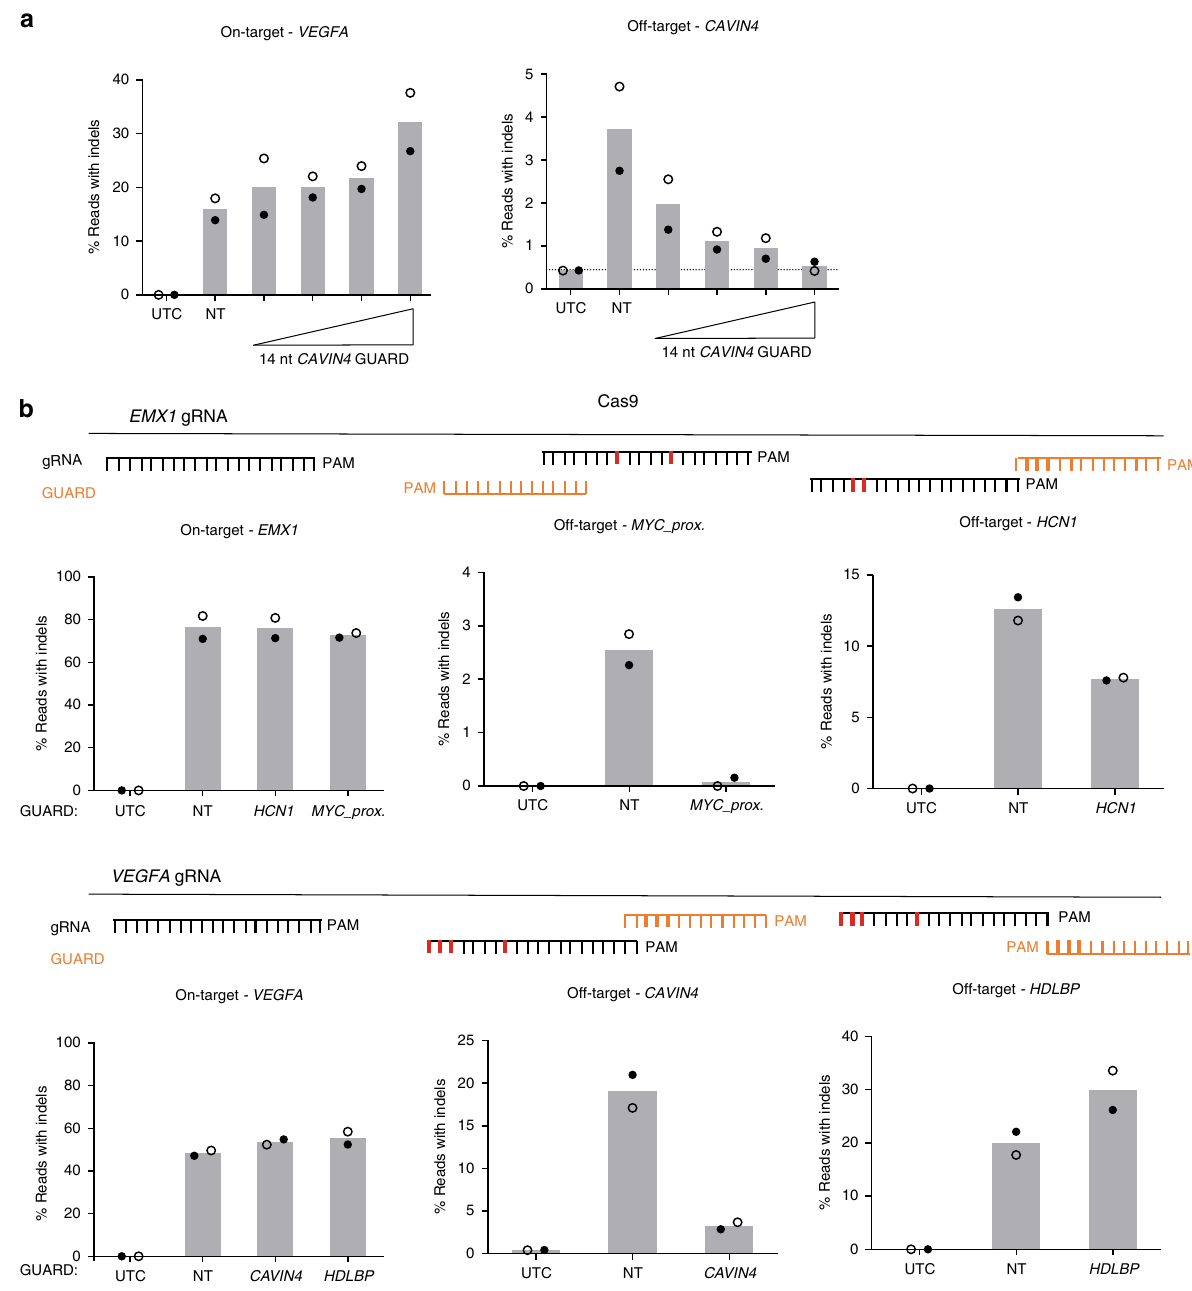
Fig. 3 Protection of multiple, endogenous off-target sites with CRISPR GUARD. a Increasing GUARD RNA concentration leads to complete protection of Cas9 off-target sites in cells. Indel rates from NGS of amplicons from Cas9-expressing HEK293 cells transfected with VEGFA gRNA and increasing concentrations of 14-nt GUARD RNA for protection of the CAVIN4 off-target site (10:10, 20:10, 50:10, 100:10 nM). The total concentration of delivered RNA in each case was kept constant by co-delivery of NT gRNA ( fi rst condition is 100 nM NT). b Indel rates from amplicons sequencing of Cas9- expressing HEK293 cells transfected with EMX1 or VEGFA on-target gRNAs, and a single GUARD RNA (25:25nM ratio). GUARD RNA positioning relative to the off-target protospacer sequence is shown schematically in each panel. Data represent the mean of two independent experiments with symbols representing each replicate. Source data are provided as a Source Data fi